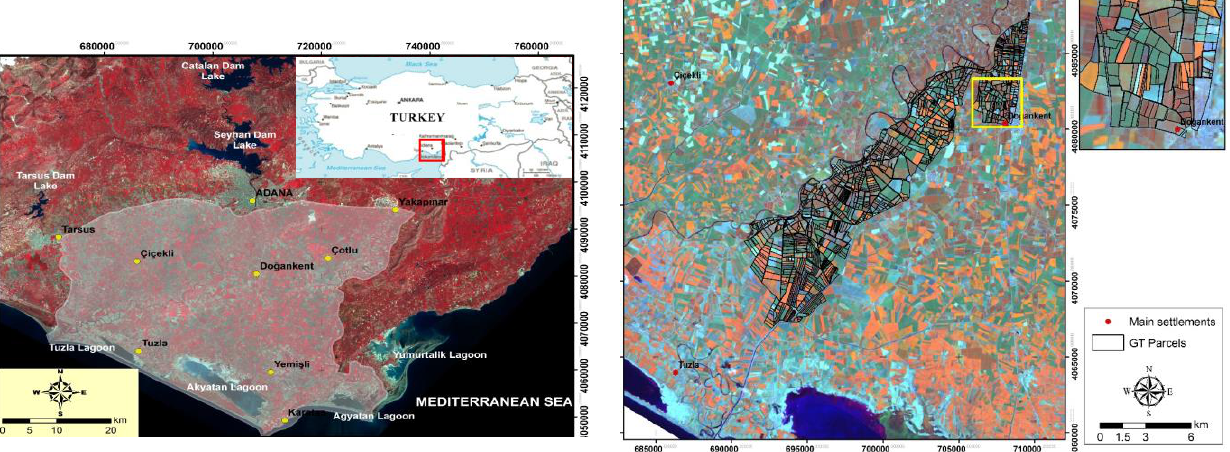
Figure 2. GT parcels